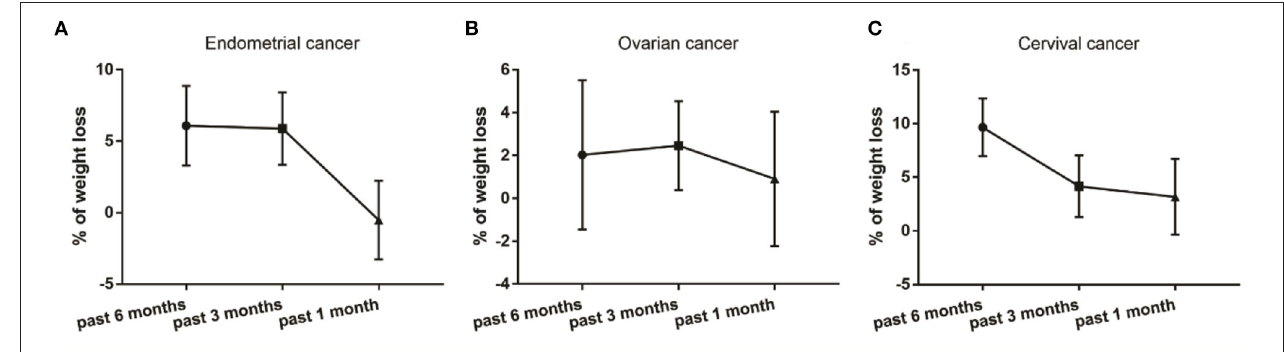
FIGURE 3 | Percentage of weight loss in patients that were diagnosed with endometrial (A) , ovarian (B) and cervical (C) cancer.